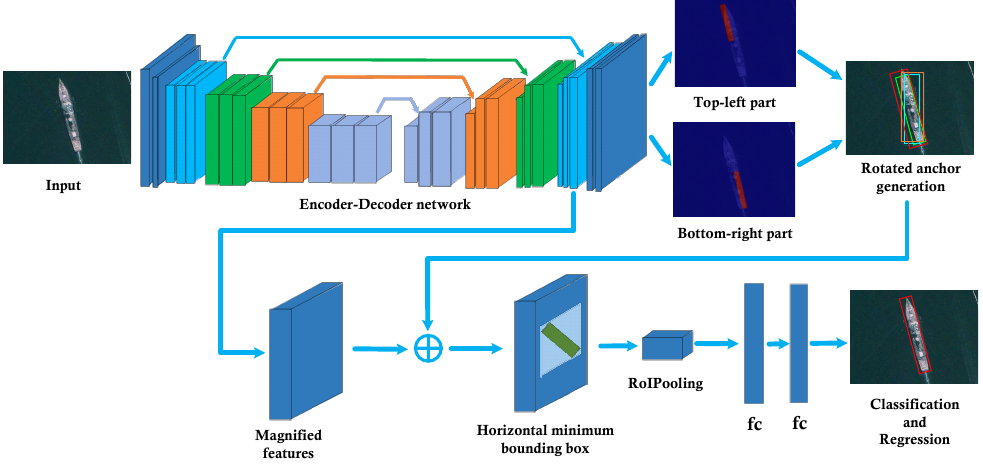
Figure 1. The network architecture of the proposed ship-detection